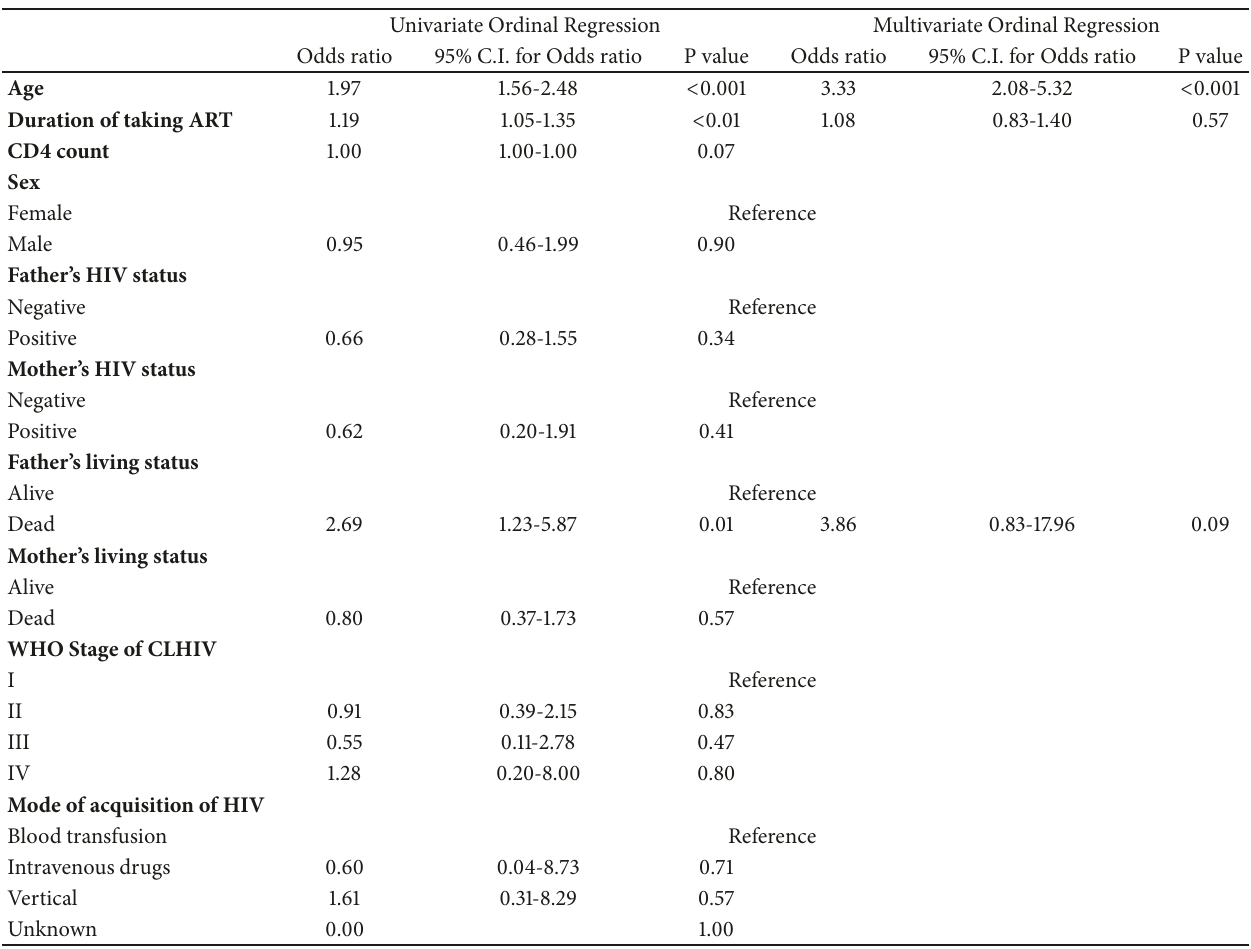
Table 2: Univariate and multivariate ordinal regression to assess factors associated with disclosure.